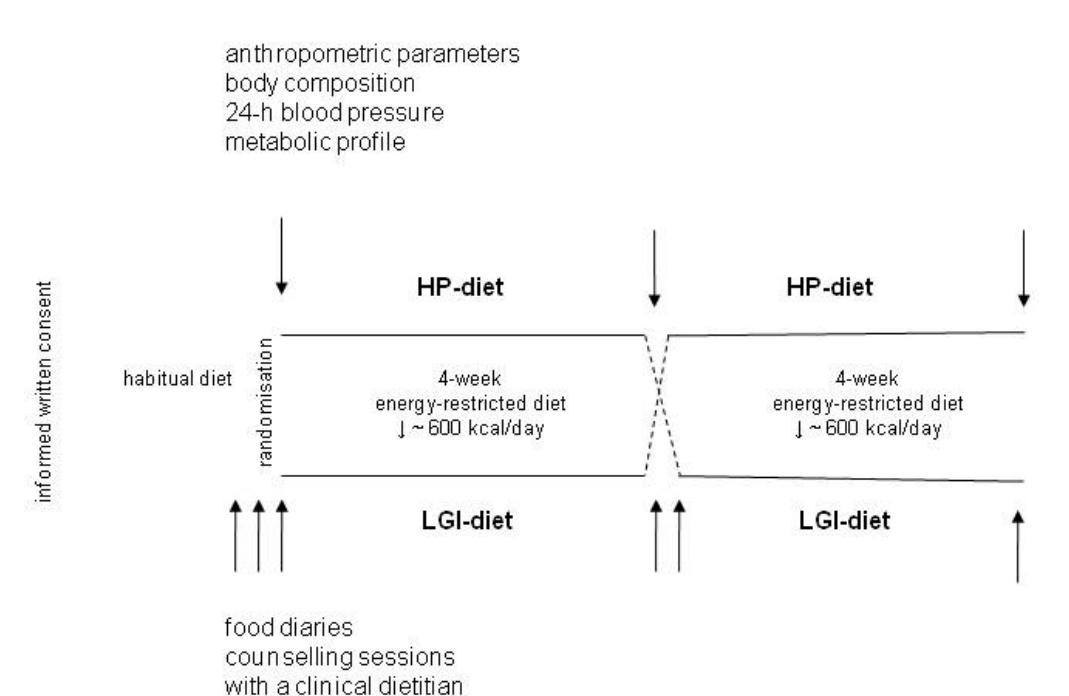
Figure 1. The crossover design of 8-week intervention with energy-restricted high-protein (HP) and low glycemic index (LGI) diets.